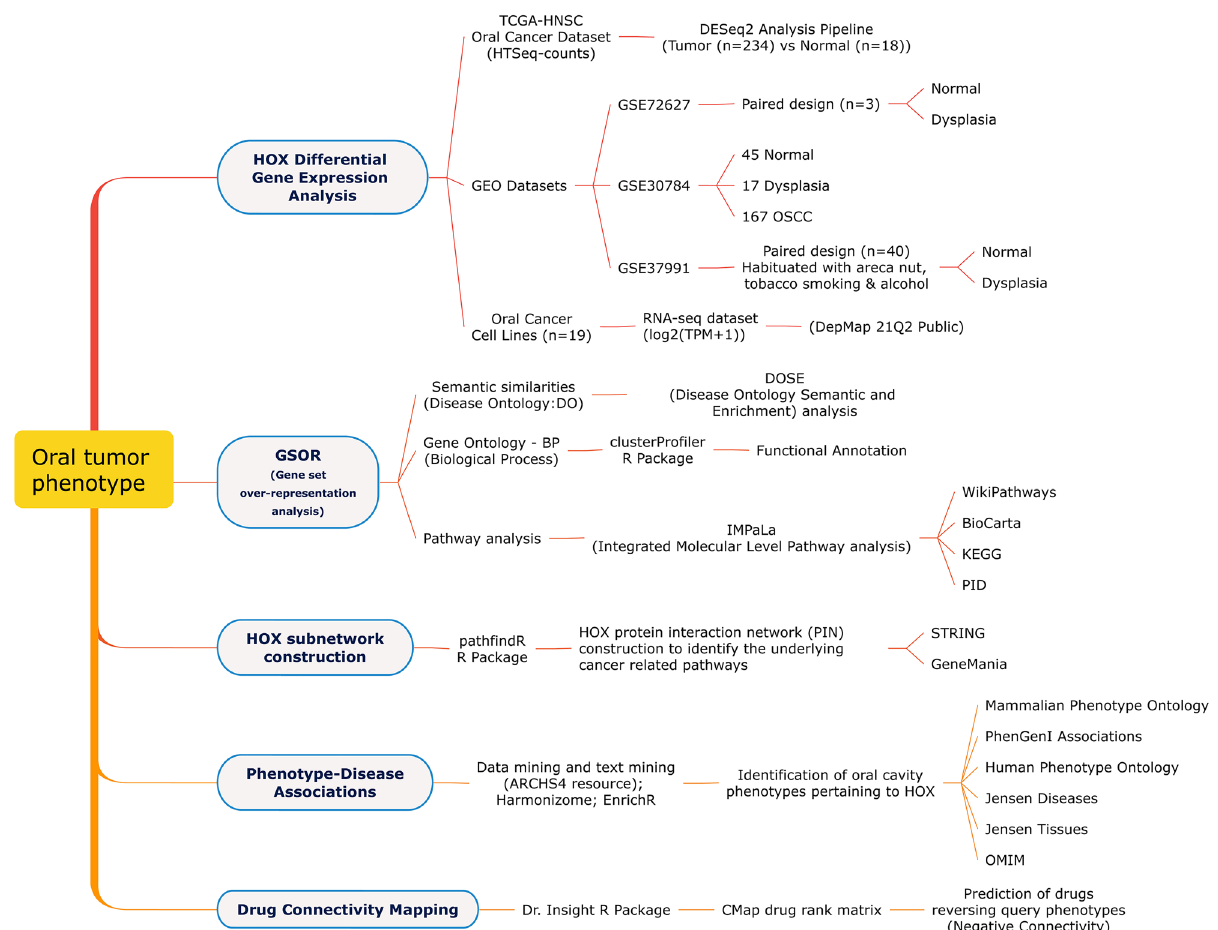
Figure 1. Schematic workflow employed to identify the HOX genes involved with oral tumor